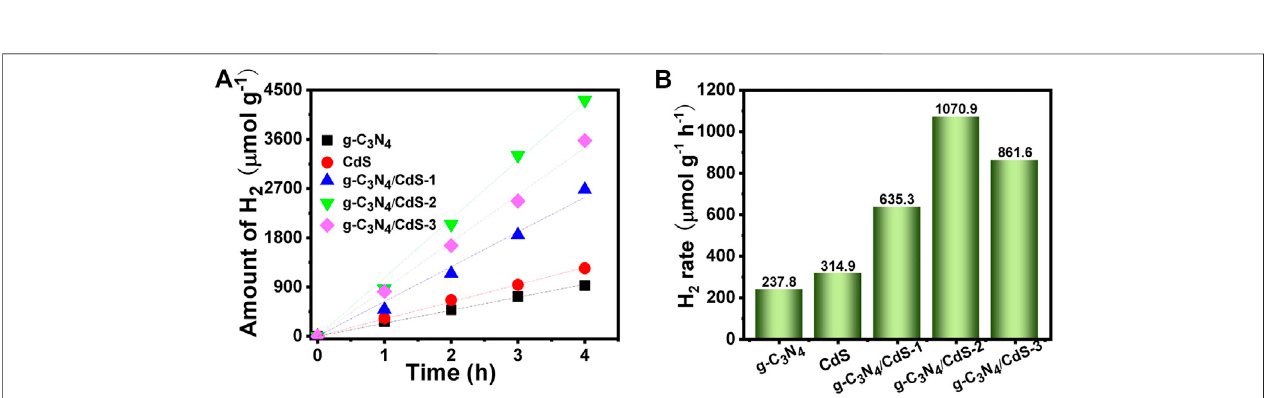
FIGURE6|(A) Comparisonofrateconstantsofg-C 3 N 4 ,CdS,andg-C 3 N 4 /CdShybridsfororganicpollutiondegradation(RhB,MB,andphenol)undervisiblelight irradiation. (B) Recyclability measurements of RhB, MB, and phenol degradation under visible light irradiation by g-C 3 N 4 /CdS hybrids.